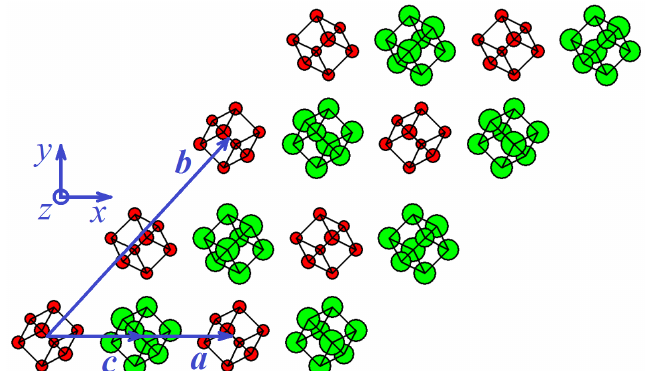
Figure 2. Structure of cubic cubene. The larger the z coordinate, the larger circle shows the carbon atom. Red (green) color is used for the lower (upper) plane of the structure (only two planes of cubenes are shown). The centers of gravity of the cubenes are close to the points of the fcc lattice. Vectors of the primitive translation cell, a , b , and c , are given by Equation (7). A primitive translational cell includes two cubenes differently oriented in